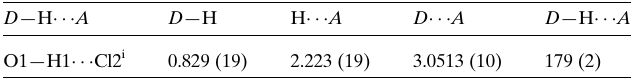
Table 1 Hydrogen-bond geometry (A˚ , (cid:4) ).